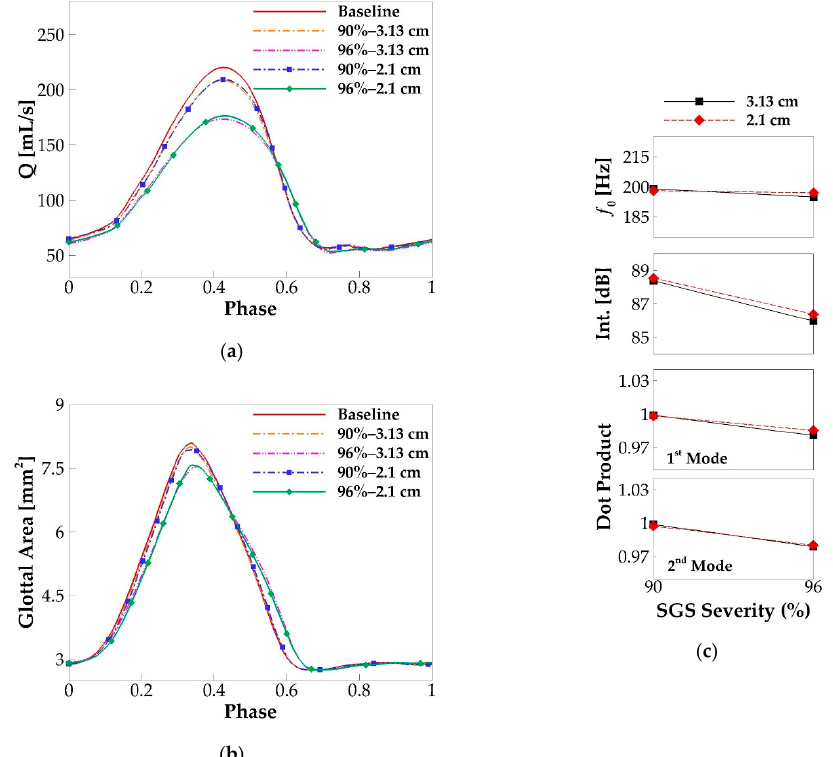
Figure 12. The comparison of the phase-averaged ( a ) flow rate waveform and ( b ) glottal area waveform in the simulation cases with the varied SGS location and severity. ( c ) The fundamental frequency, sound intensity, and similarity of the corresponding modes in the cases with the varied SGS location and severity.